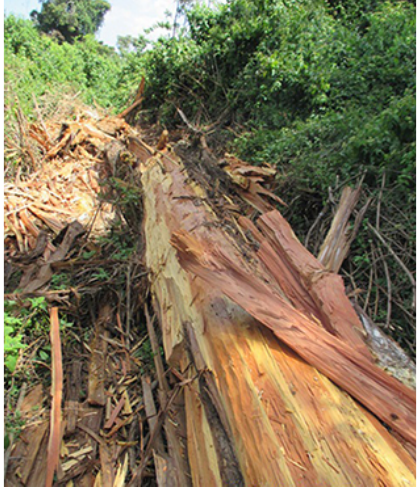
Figure 14. Illegal logging of cedar trees in the forest (Photo: Donald Kipruto Kimutai, 18 July 2015).